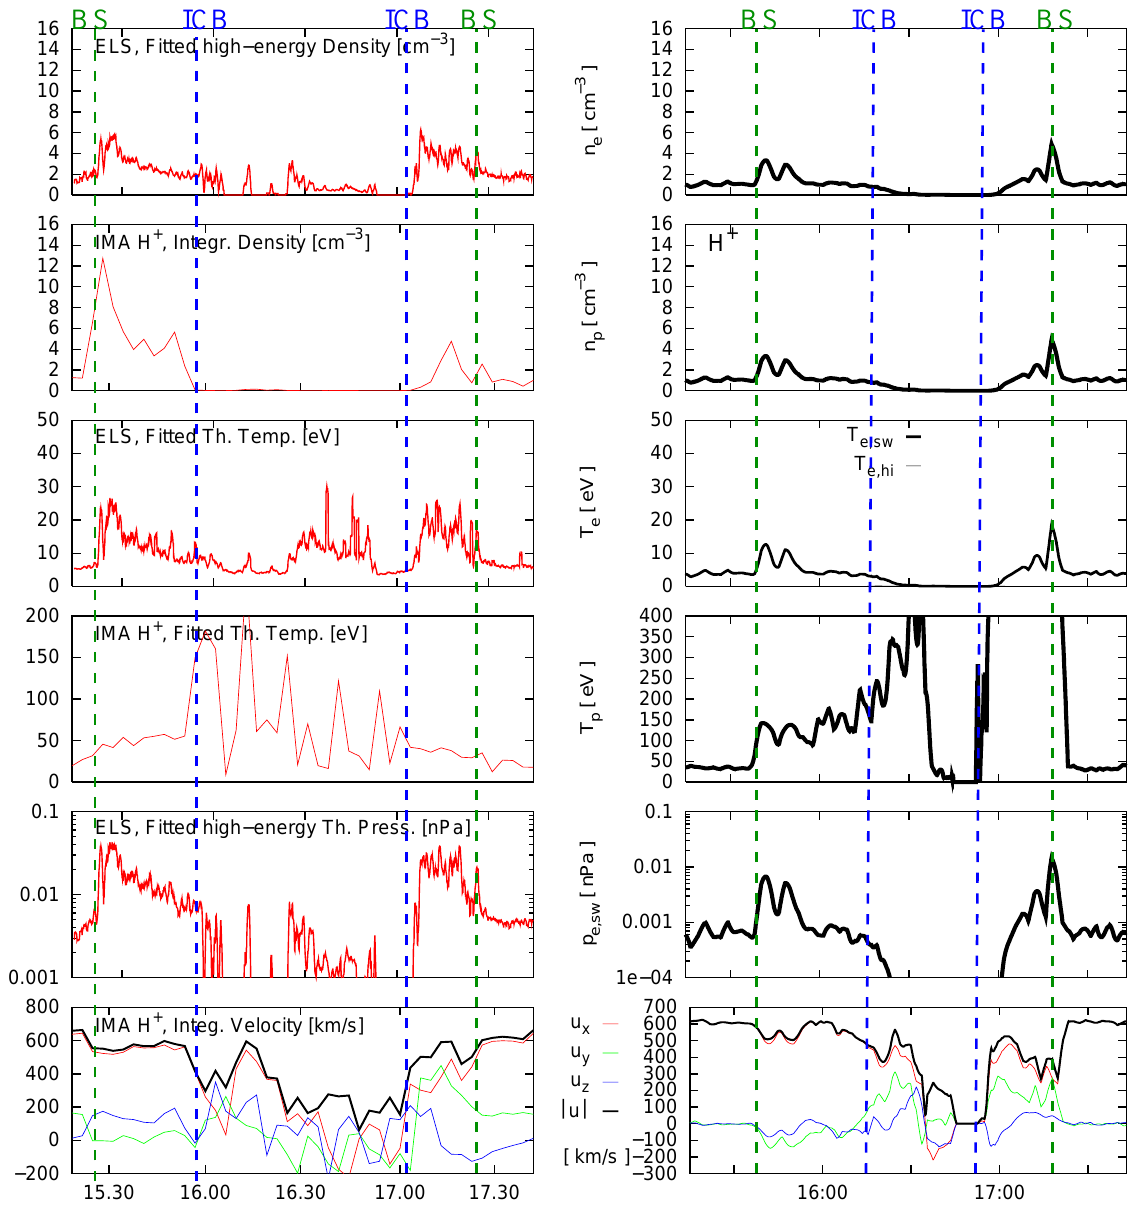
Fig. 9. Smoothed ELS und IMA data at the left hand side is represented in direct comparison with results from a second hybrid simulation on the right hand side. The positions of the bow shock and of the ICB/MPB are marked in green and blue dashed lines. Displayed are from top to bottom the same quantities as in Fig. 8. This simulation results using adaptive solar wind parameter show a good quantitative agreement with data obtained from ASPERA-3/MEX. The inbound crossings of the bow shock and the ICB/MPB appear in this simulation about 15min